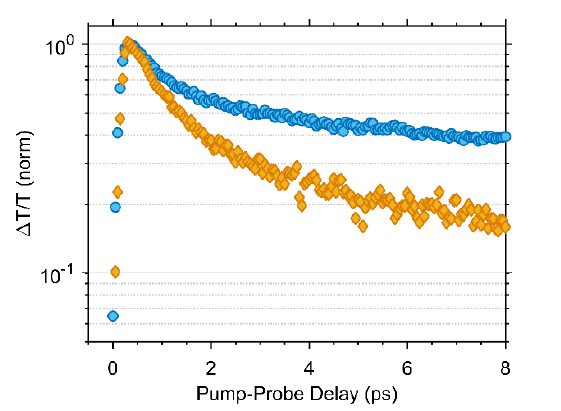
Fig. 1. Normalized transient transmission ( Δ𝑇/𝑇 ) dynamics around the spectral position of the C exciton for different probe polarization direction: parallel (circles) and orthogonal (diamonds) to the corrugation